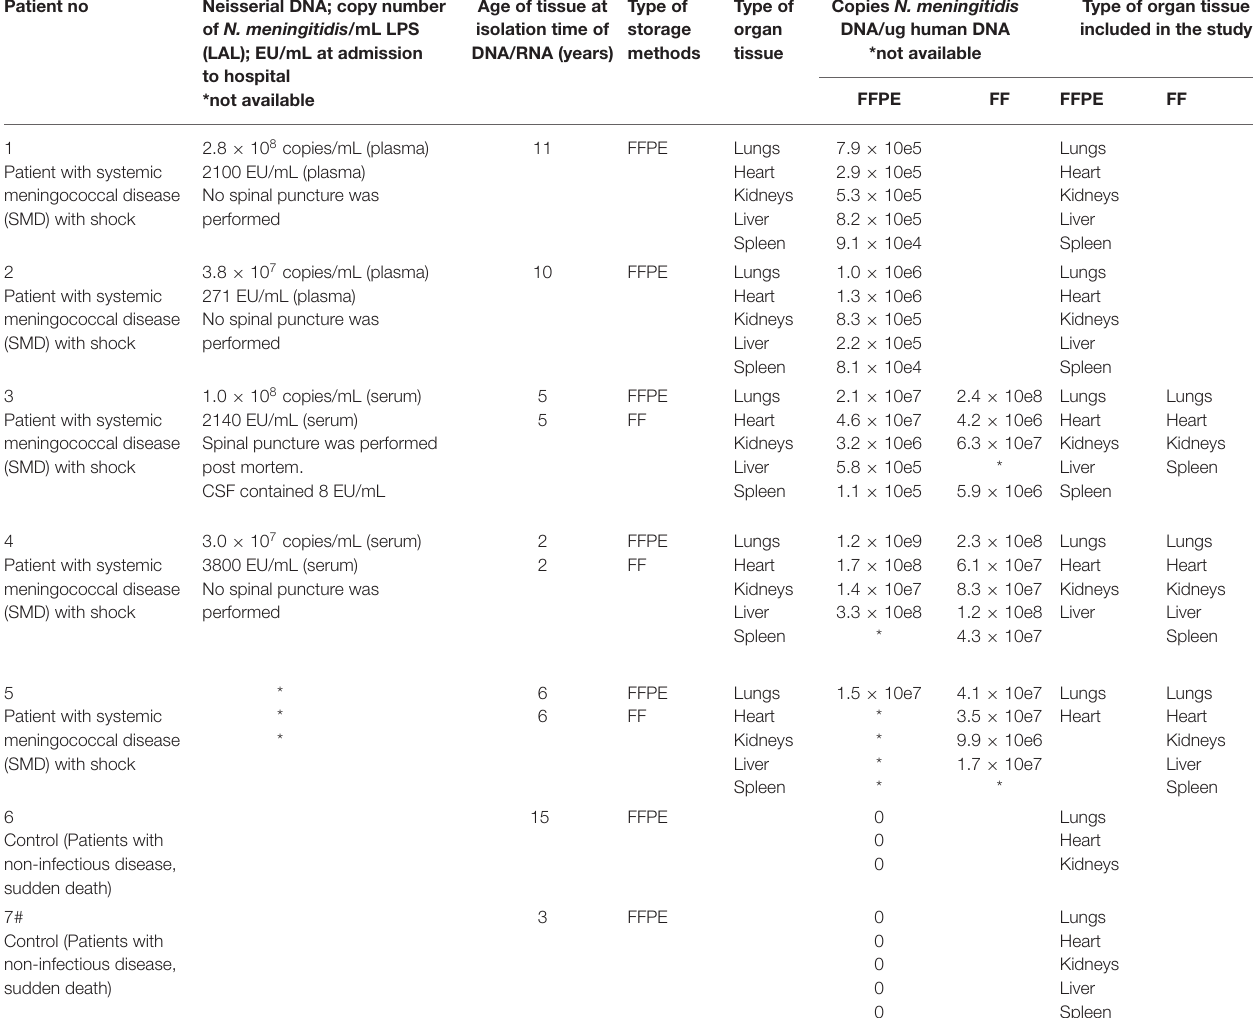
TABLE 1 | Overview of patients, clinical data, storage age of tissue, and type of tissue. Patient